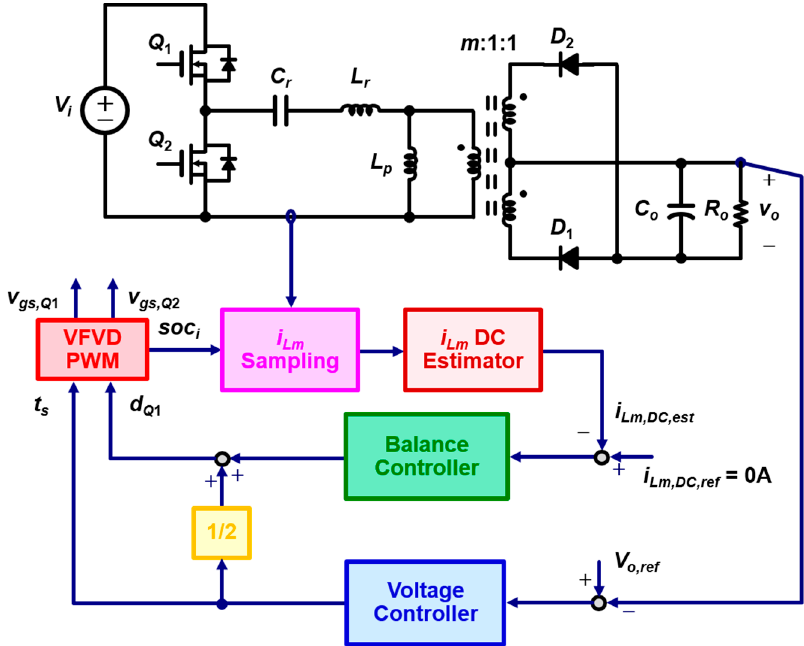
Figure 7. Overall block diagram of the proposed control architecture.